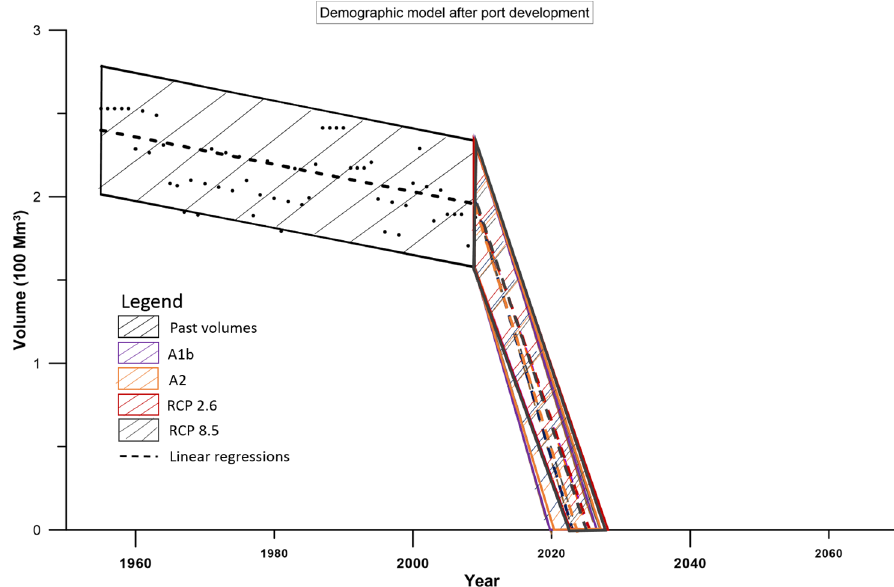
Figure 12. Graph, with the shaded areas representing the effective volume of Shela aquifer and projected volumes for all four climate change scenarios, as well as the uncertainties for the demographic model with the port construction completed (“LAPSSET development projected”).